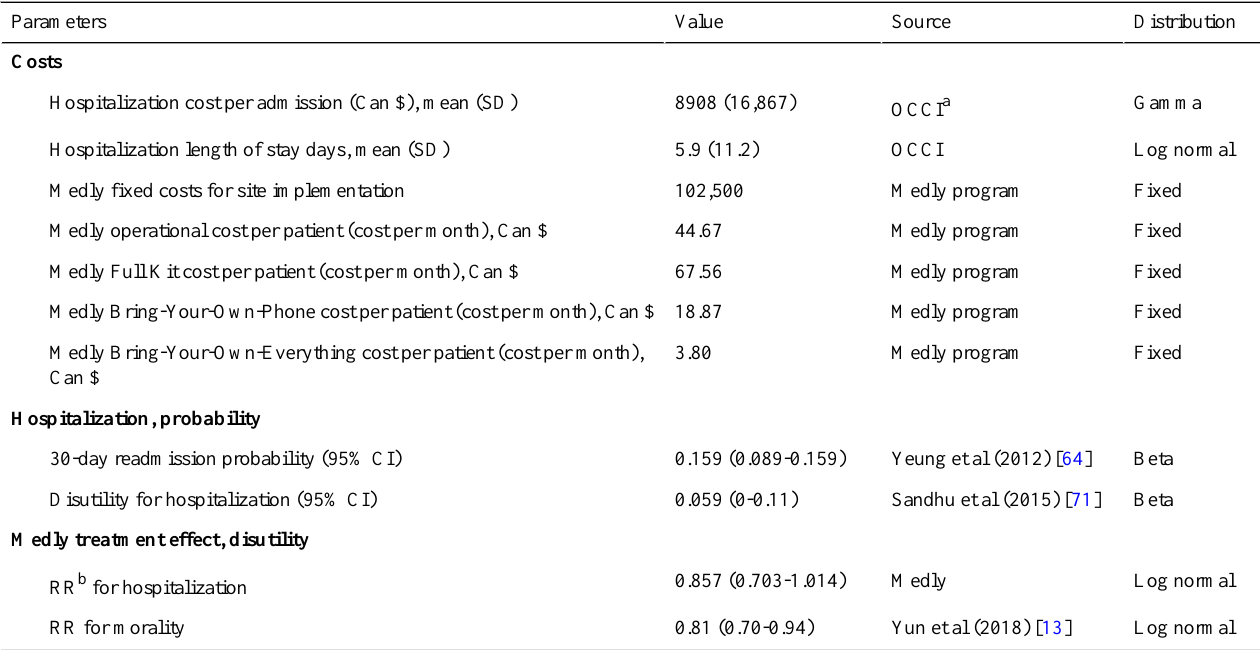
Table 4. Parameter estimates not conditional on the New York Health Association class including hospitalization costs (in Can currency) and disutility, readmission rates, Medly costs (in Can currency), and Medly effectiveness